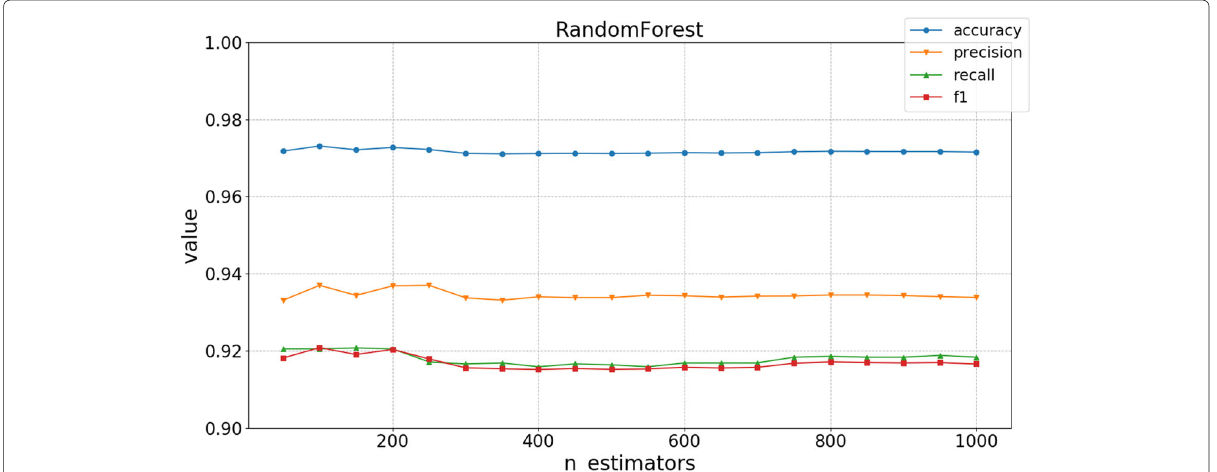
Fig. 6 Result of Random Forest with regard to n _ estimators . The accuracy is above 96%, and the rest of the three metrics are above 90% and their values keep nearly stable over different values of n _ estimators . The system gets a better performance, when n _ estimators is about